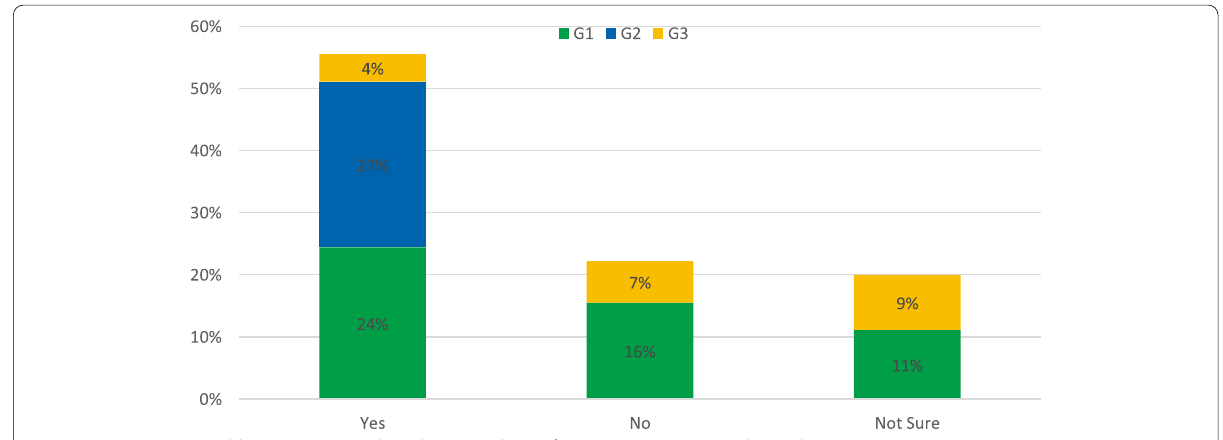
Fig. 4 Response to: Would you support a pilot scheme to charge for access to certain roads or urban